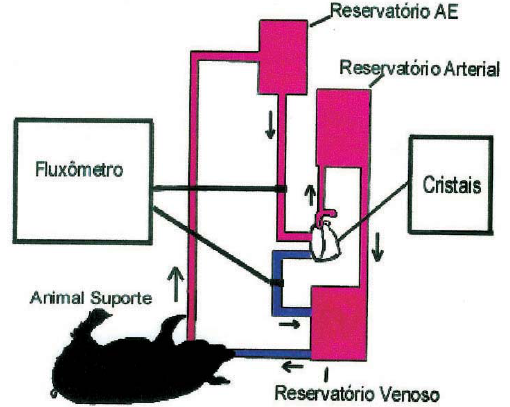
Fig. 3 - Esquema do sistema de perfusão. Em modo “working heart”